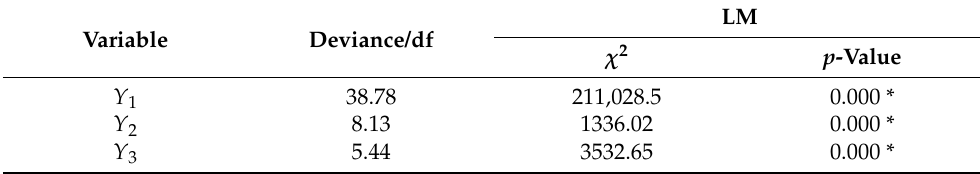
Table 3. Overdispersion test.